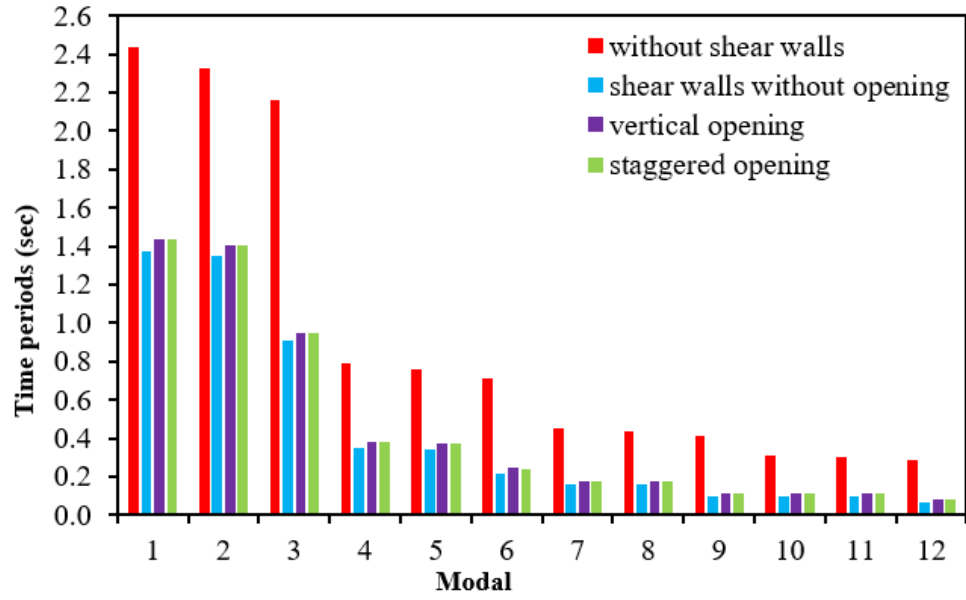
Figure 23. The time period of the models.